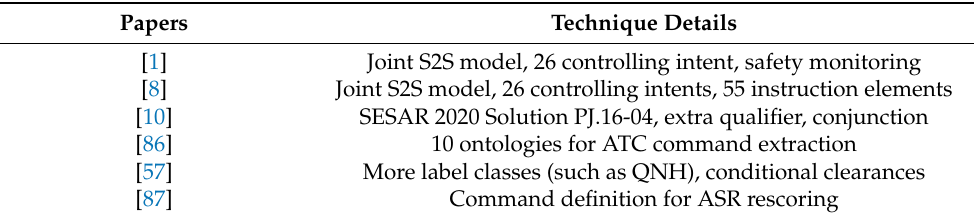
Table 6. The language understanding-related studies in the ATC domain.